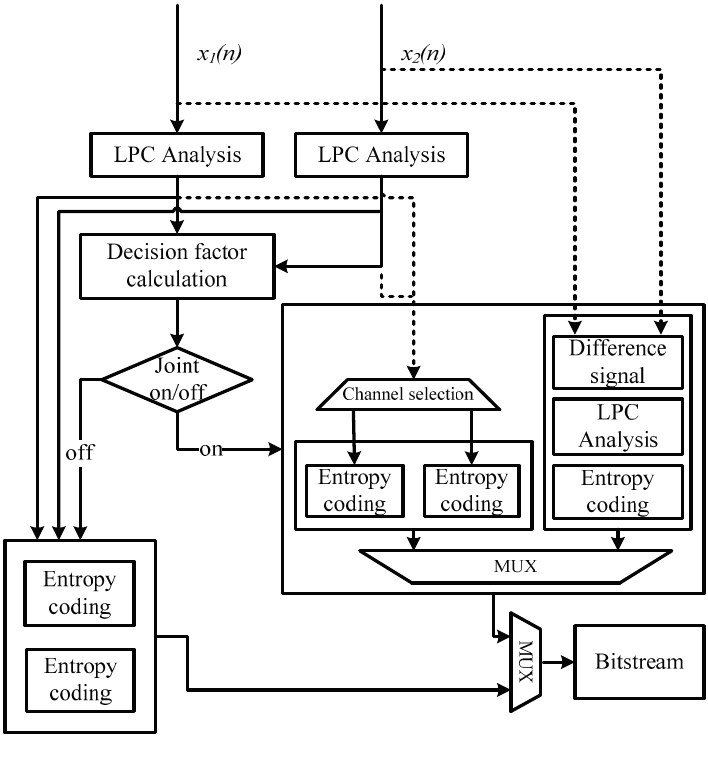
Figure 4. Proposed low-complexity joint-coding